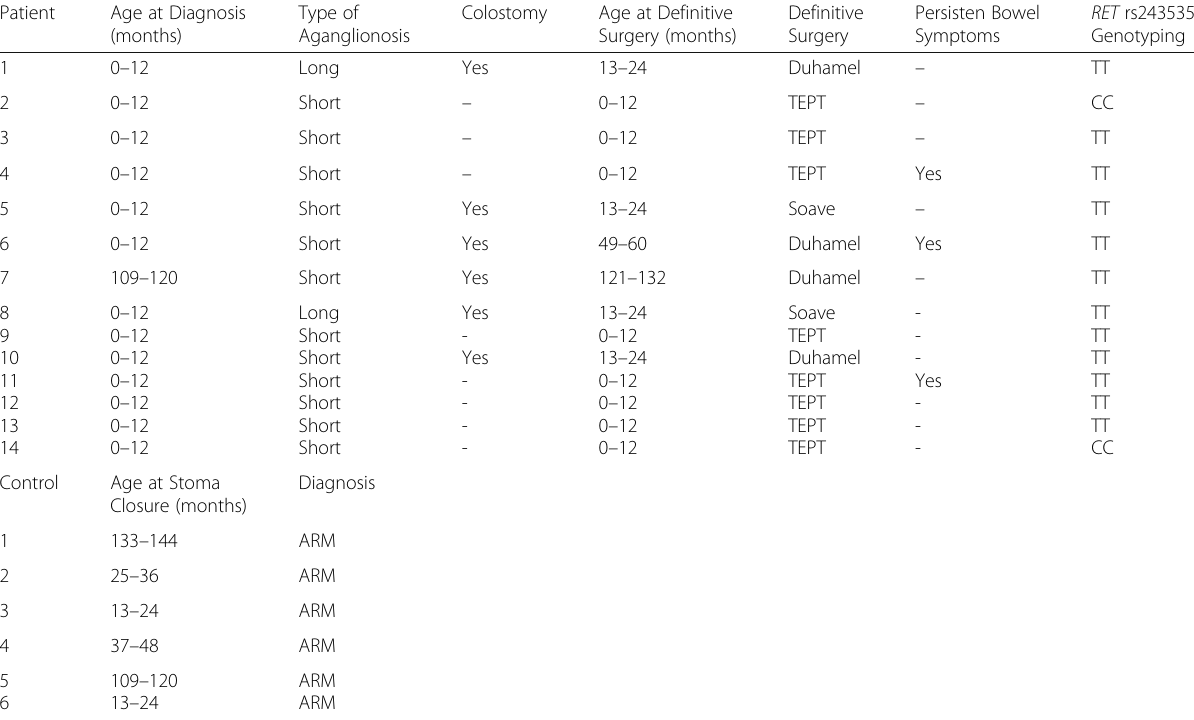
Table 1 Clinical characteristics of Indonesian HSCR patients following definitive surgery and controls